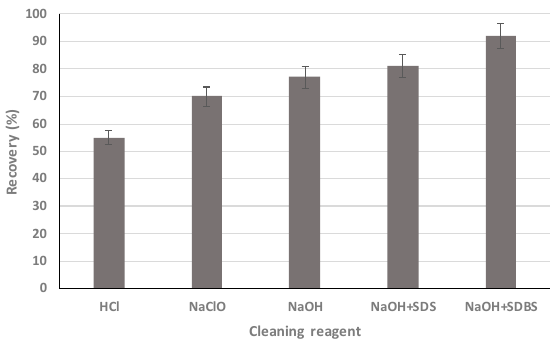
Figure 5. Efficiency comparison of different chemical cleaning reagents (error = ±5%). Figure 5. E ffi ciency comparison of di ff erent chemical cleaning reagents (error = ±